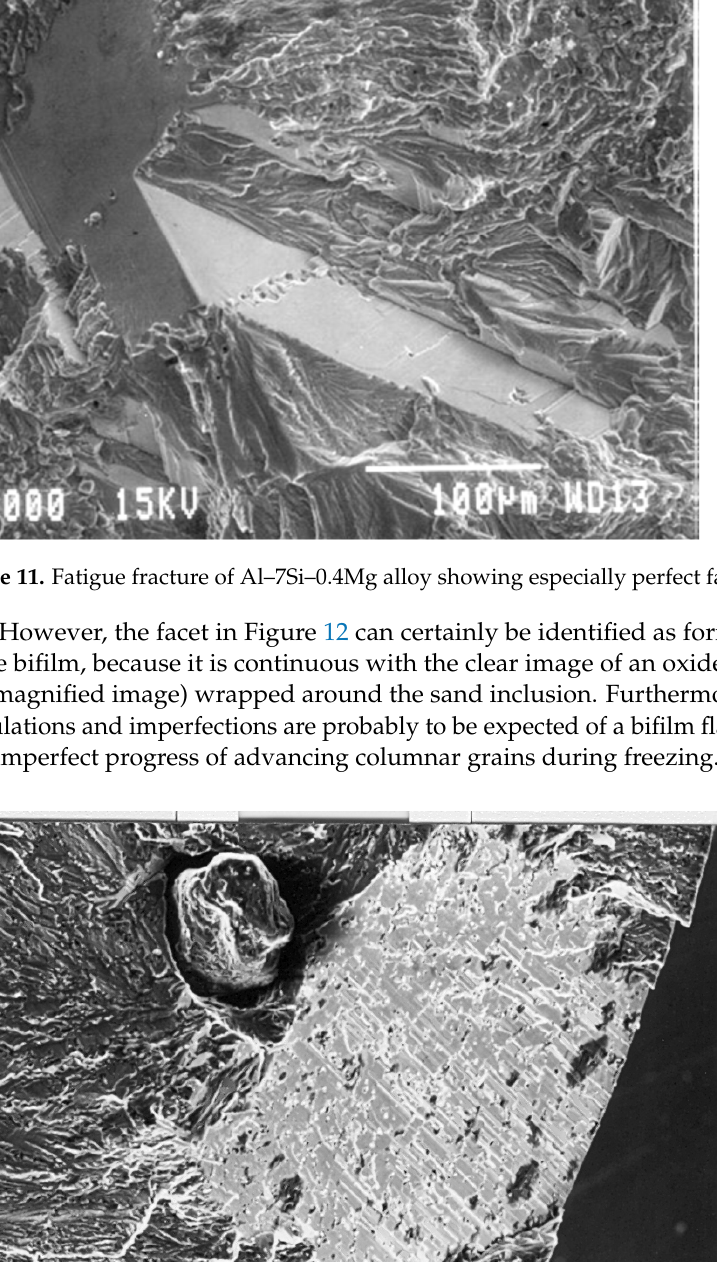
Figure 12. Fatigue fracture of Al–7Si–0.4Mg alloy showing facet generated from the oxide bifilm partly wrapped around the entrained sand grain [35].